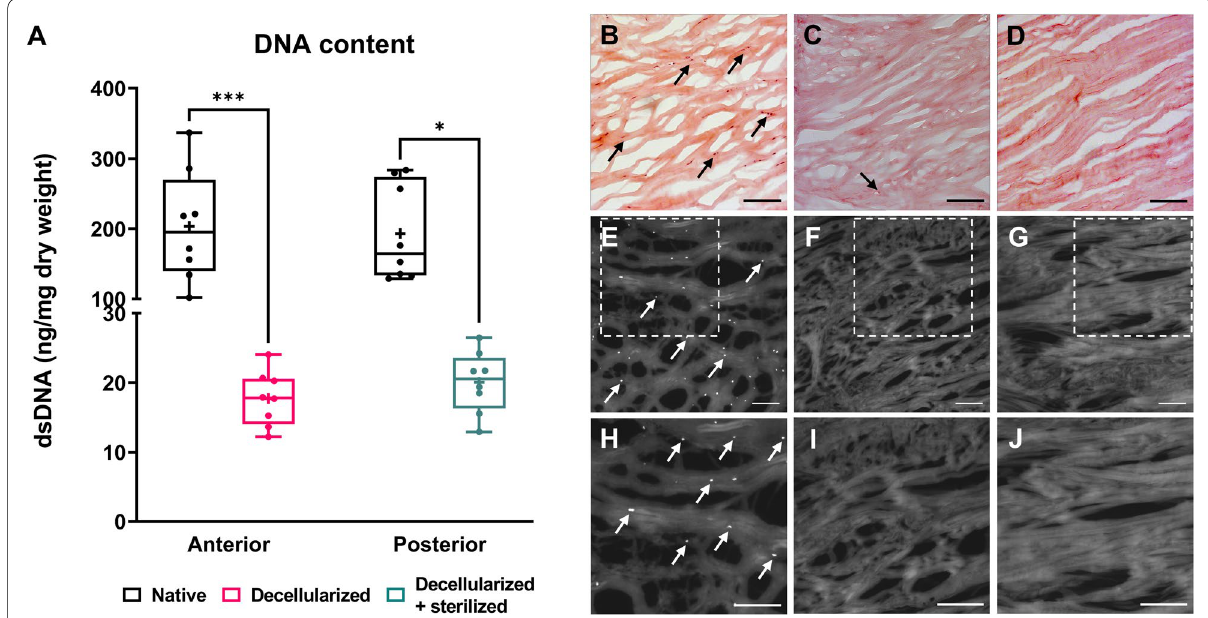
Fig. 2 Meniscus tissue is efficiently decellularized. A DNA content in native, decellularized and decellularized indicates a p -value of < 0.05, *** indicates a p-value of < 0.001. Box plots show all data points with median, maximum value, minimum value, and 25th and 75th percentiles. B - D Histological sections of native ( B ), decellularized ( C ), and decellularized with H&E. E - G Histological sections of native ( E ), decellularized ( F ), and decellularized magnification of DAPI stained sections of native ( H ), decellularized ( I ), and decellularized arrows. Scale bar represents 100